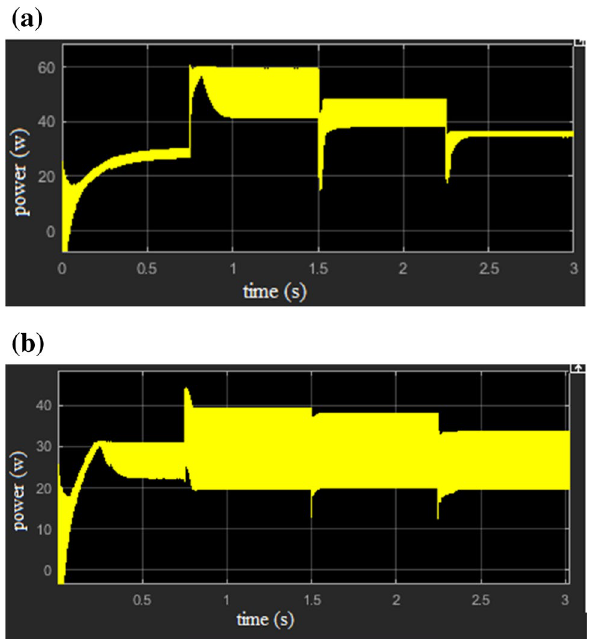
Fig. 7 a Output power with conventional P&O method. b Output power (thermography MPPT)